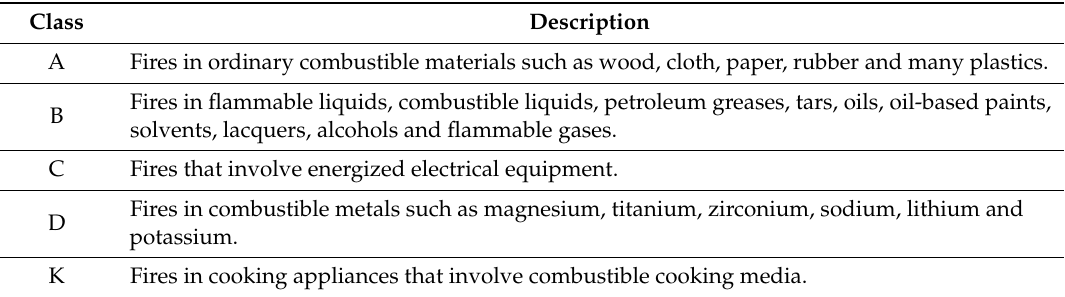
Table 5. Classification of